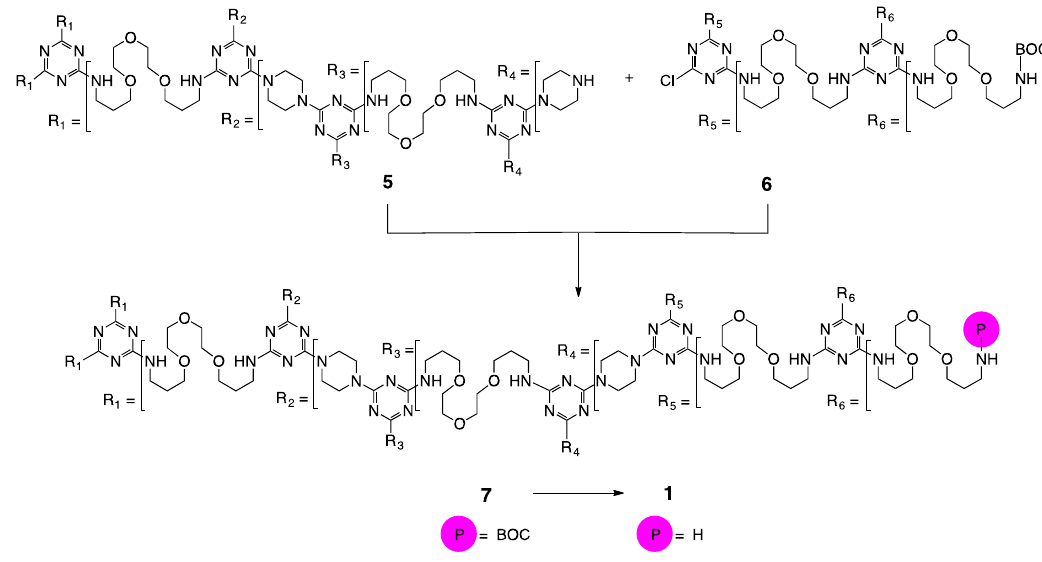
Figure 2. The synthesis of 1 relies on the use of 5 and 6 [12].